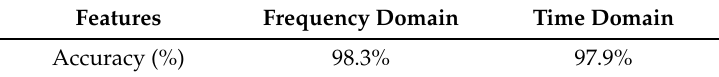
Table 4. Correct differentiation rates of frequency and time domain.